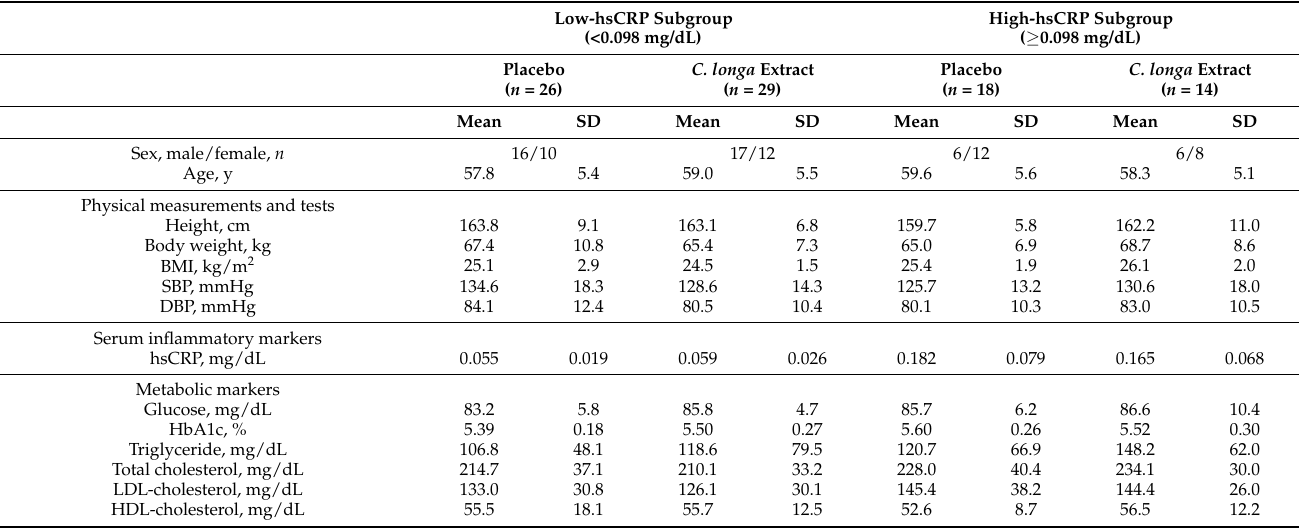
Table 2. Baseline characteristics of the participants stratified by serum hsCRP levels in study 1 1 .